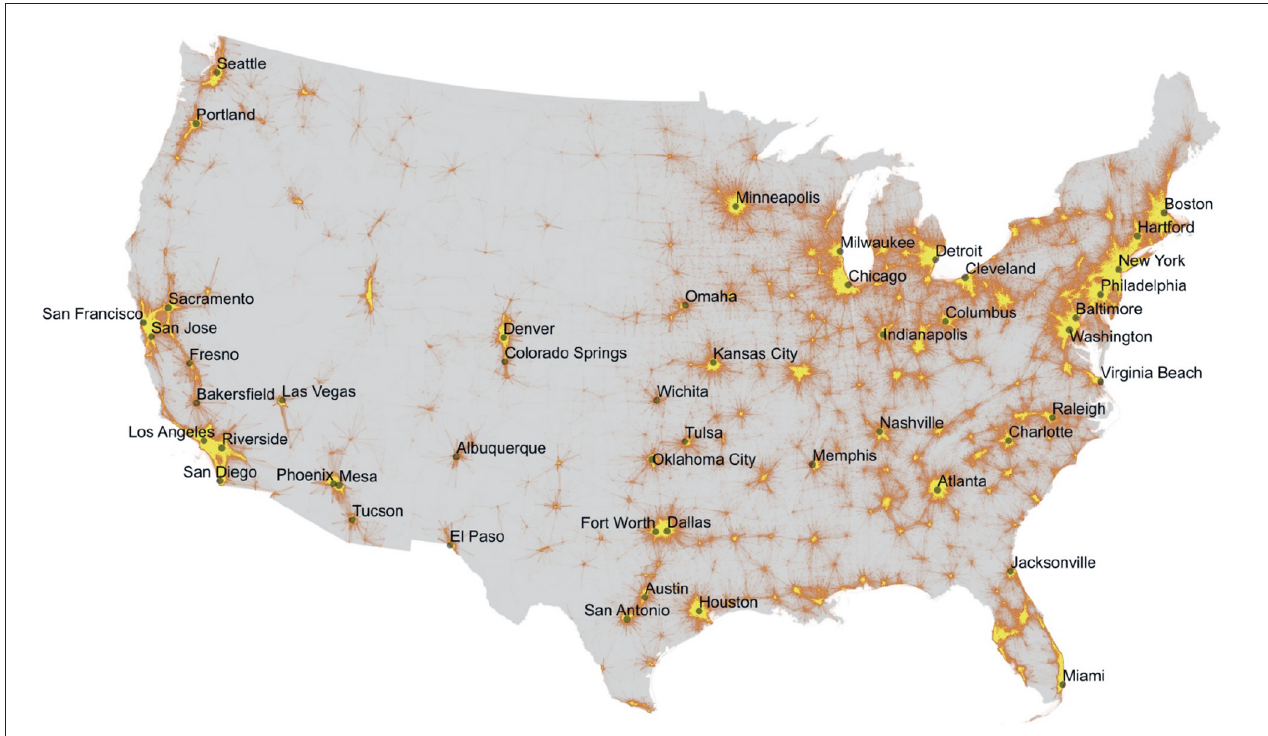
FIGURE 2 | Urban Archipelagos and Corridors. This map shows patterns of commuter movement into and out of cities in the United States, color coded as a function of the density of commuters. Yellow shows areas with high densities of people and movement. Orange indicates an intermediate density of overlapping commutes. On the one hand, this map emphasizes the isolation of many cities, particularly, for example, cities of the intermountain West, and also the isolation of some groups of cities, such as those of California, relative to other cities, such as those of the Northeast. On the other hand, however, this map shows a measure of the extent to which cities can serve as corridors for species able to move with humans in vehicles or along roads. Highlighted here as well are cities mentioned elsewhere in the article, including the Northeastern megacity (note the modest break located around Connecticut) and, within it, Manhattan. Data are from Nelson and Rae